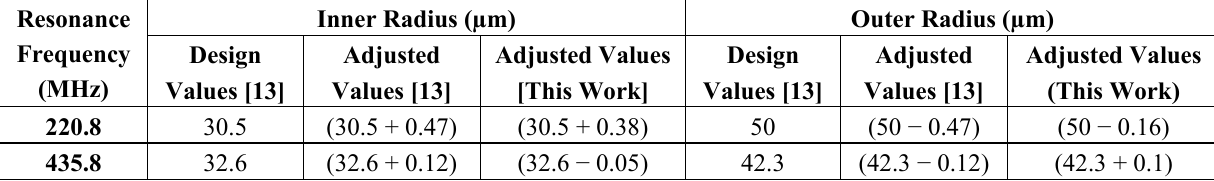
Table 3. Designed parameters of polysilicon ring